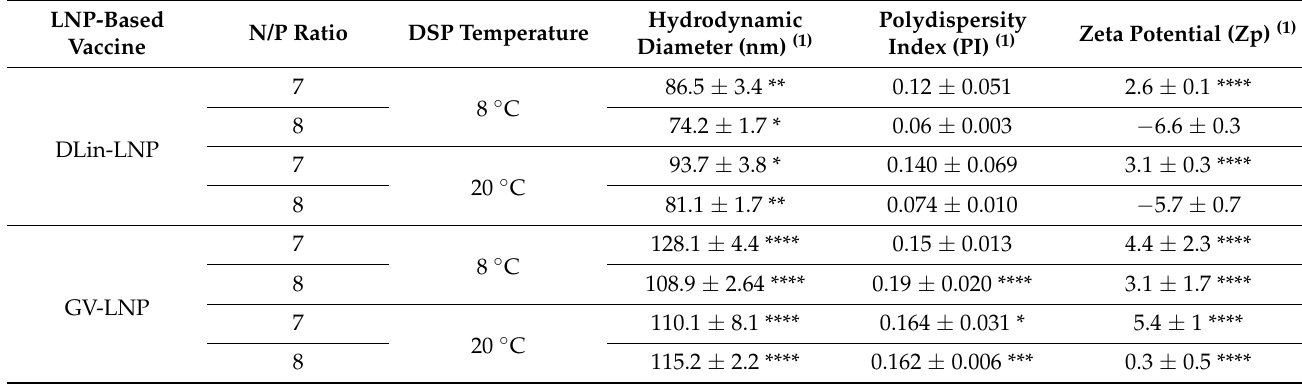
Table 2. Characterization of DLin- and GV-based LNPs under hypotonic condition.